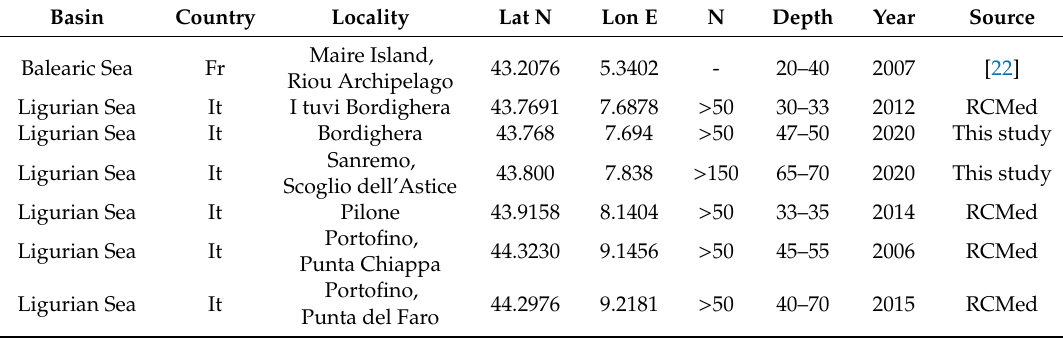
Figure 5. Distribution of Eunicella verrucosa in the Mediterranean Sea. ( a ) Global view, ( b ) detail of the Liguro–Provencal coast. Small dots indicate few / isolated colonies, while large dots represent forests of E. verrucosa . Table 1. Localization, depth (m), and abundance (N: number of colonies) of the 19 Eunicella verrucosa forests identified in the Mediterranean Sea, with indication of the latest update and the source of the data. Fr: France; It: Italy; Mo: Montenegro; RCMed: Reef Check Mediterranean.